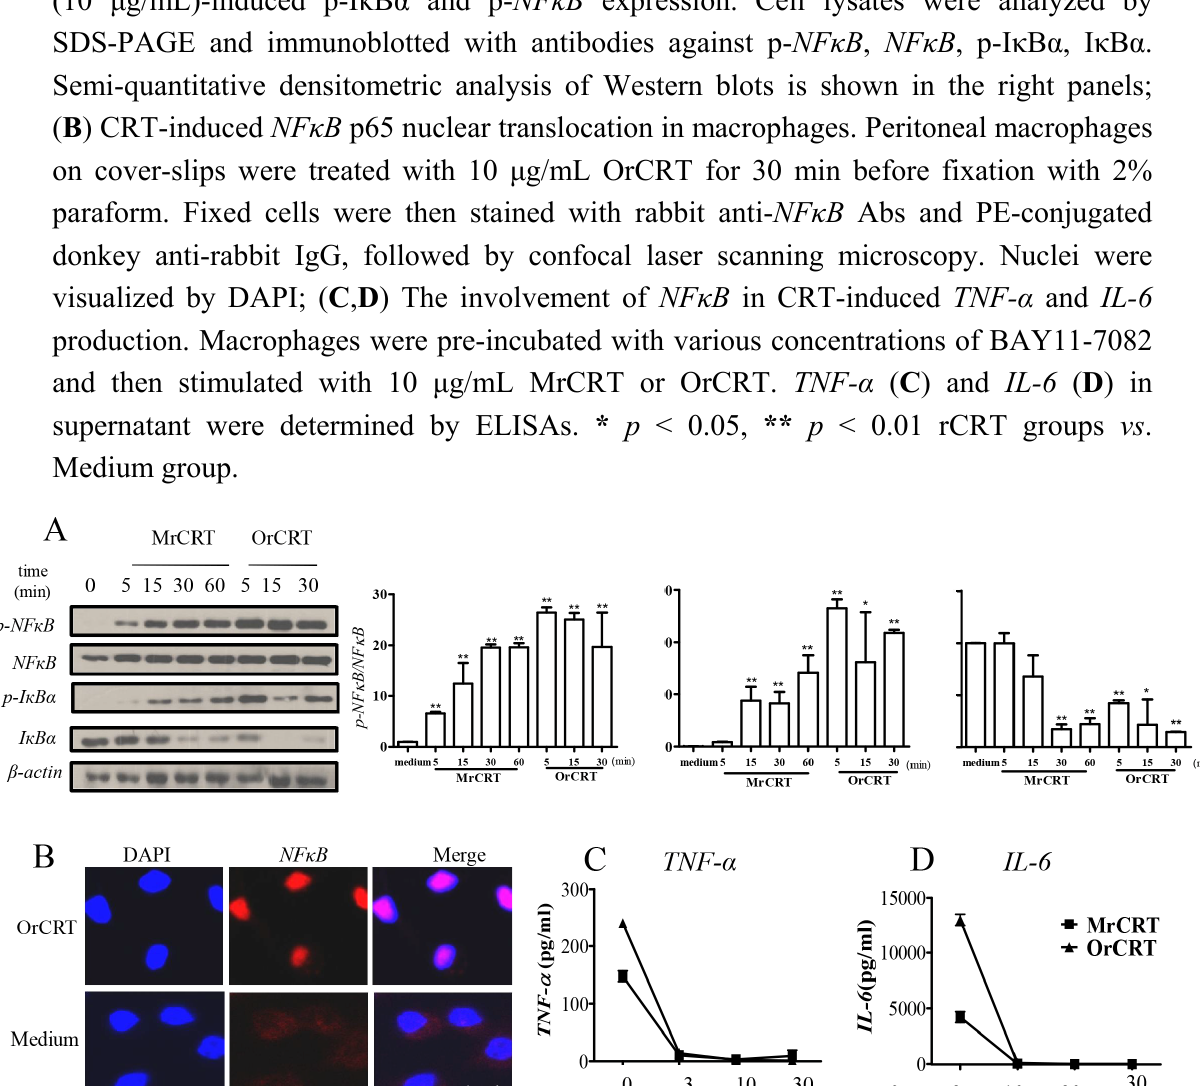
Figure 3. The I κ B kinase (IKK)/ NF κ B pathway is required for CRT-induced TNF- α and IL-6 production in macrophages. ( A ) Kinetic analysis of MrCRT or OrCRT (10 μ g/mL)-induced p-I κ B α and p- NF κ B expression. Cell lysates were analyzed by SDS-PAGE and immunoblotted with antibodies against p- NF κ B , NF κ B , p-I κ B α , I κ B α . Semi-quantitative densitometric analysis of Western blots is shown in the right panels; ( B ) CRT-induced NF κ B p65 nuclear translocation in macrophages. Peritoneal